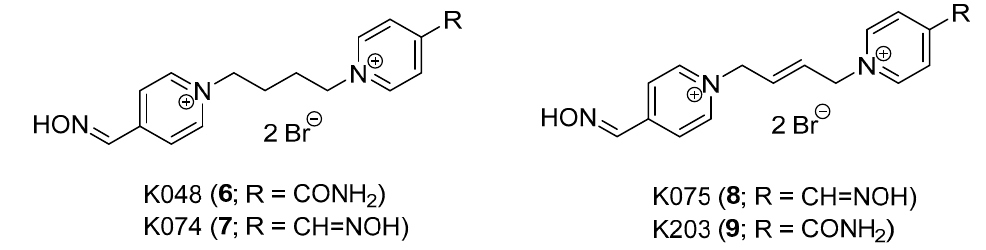
Figure 3. Promising formerly developed AChE reactivators.